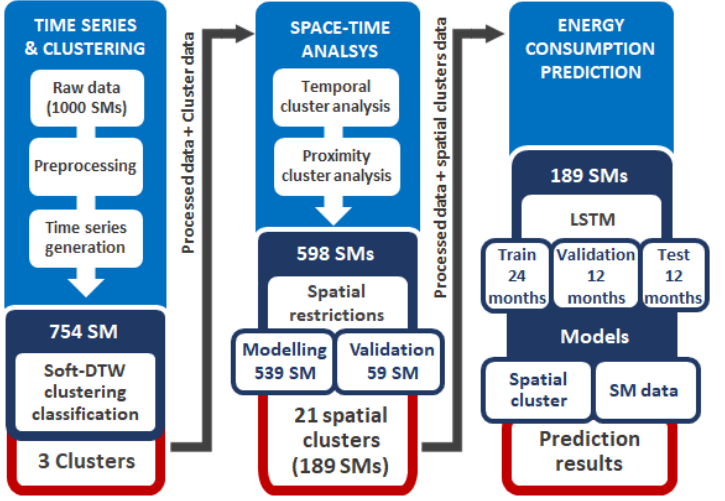
Figure 1. Summary of the methodology and filtered dataset obtained at each